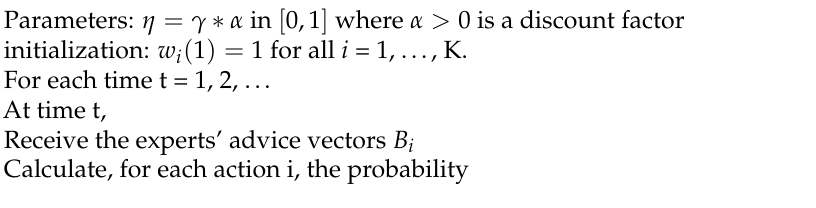
Algorithm 1 The M-EXP3 Algorithm with the